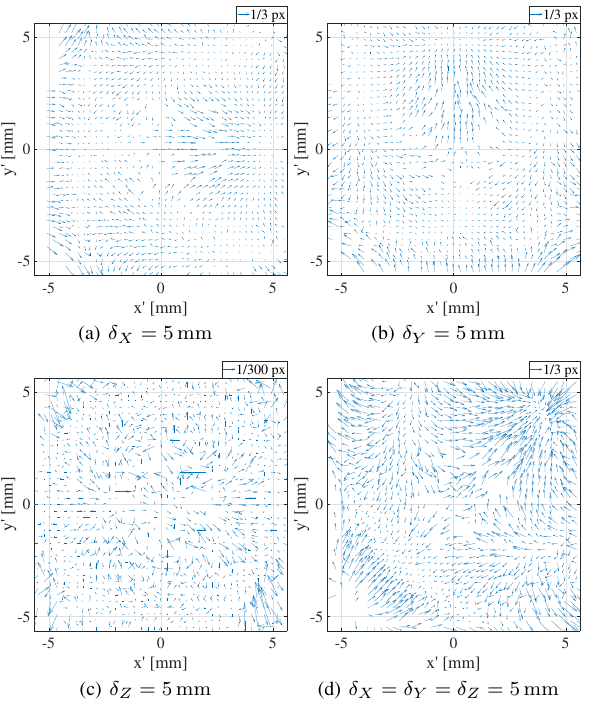
Figure 3. Residual pattern for simulated dome center offsets for offsets in X (a), Y (b), Z (c) and XYZ combined (d). Especially lateral offsets cause systematic residual patterns whereas longitudinal deviations (Z-direction) are well absorbed by the Brown model. Note: (c) is scaled by factor 100. perfectly axis-symmetrical behavior would be anticipated for shifts in δ X and δ Y and point-symmetrical for δ Z which is only approximately the case. The residual asymmetries most likely arise from an irregular point and camera station network from the original data set which was the base for this simulation.